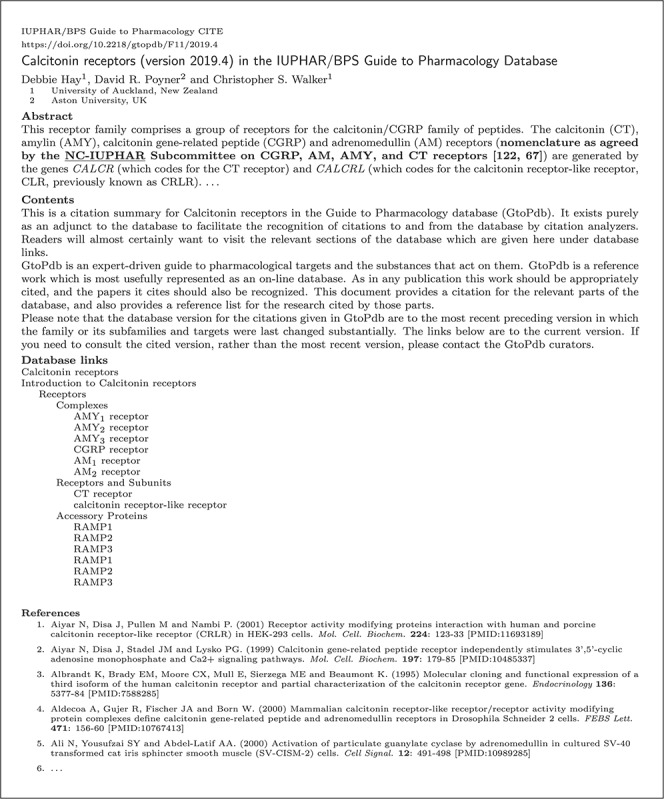
Figure 8 Shows a heavily redacted (for reasons of space) summary that has been generated from GtoPdb. This is a paper (24) in the OJS Journal GtoPdb CITE. Electronic versions of this summary should provide working hypertext links to appropriate sections of the database and cited material.